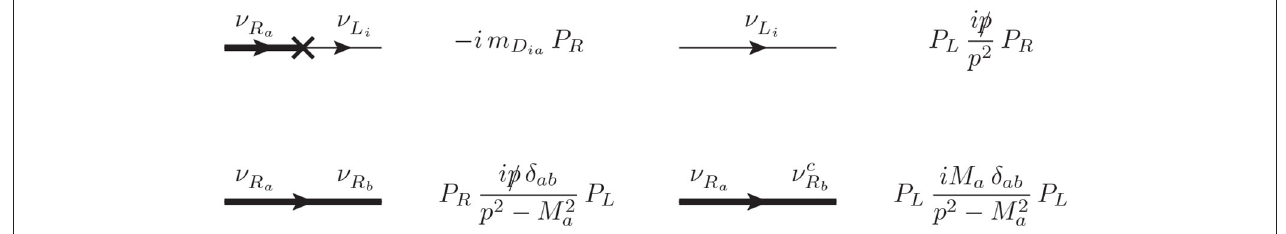
ℓ k ¯ ℓ m in the neutrino mass basis. →